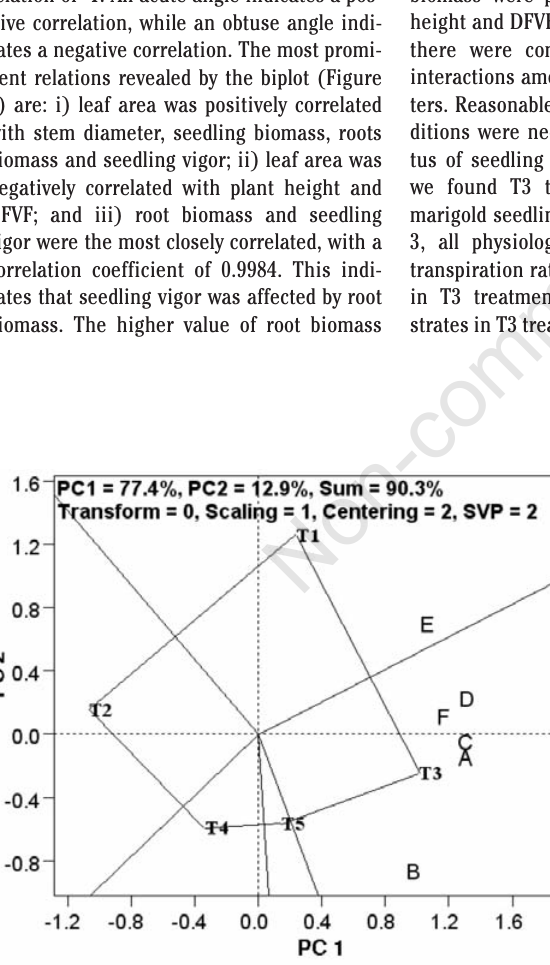
Figure 4. Correlations among different treatments and their Figure 3. Different treatments affect the physiological growth effects on physiological growth parameters of marigold seedling. parameters of marigold seedling. A, chlorophyll content; B, pho- A, chlorophyll content; B, photosynthetic rate; C, root activity; tosynthetic rate; C, root activity; D, stomatal conductance; E, D, stomatal conductance; E, transpiration rate; F, intercellular transpiration rate; F, intercellular CO concentration. CO 2 2